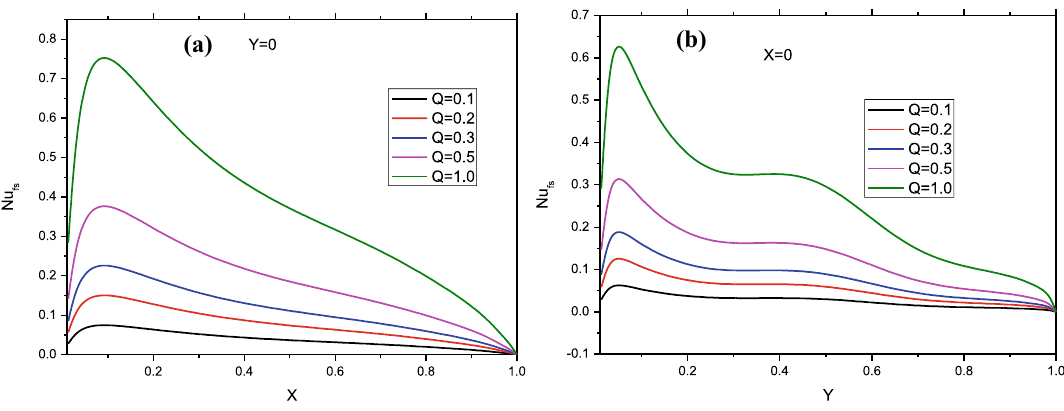
Fig. 5 Heat generation heat transfer parameter profiles of the local Nusselt number of fluid phase for TiO Ha = 10 ,Da = 10 – 3 , Ri = 1 , Gr